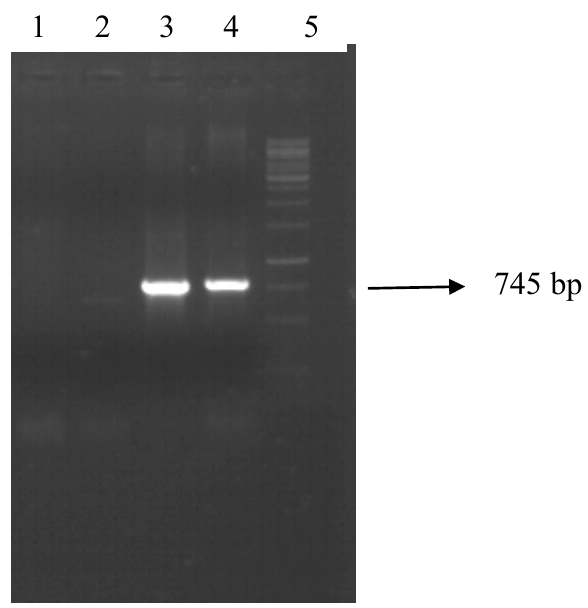
Figure 1. Amplification of PhlD gene involved in synthesis of 2,4-diacetylphloroglucinol (DAPG). Lane 1, 2, Ochrobac- trum intermedium strain NH-5; lane 3, 4, Pseudomonas fluo- rescence CHA0; lane 5, 1kb Ladder (Fermentas).